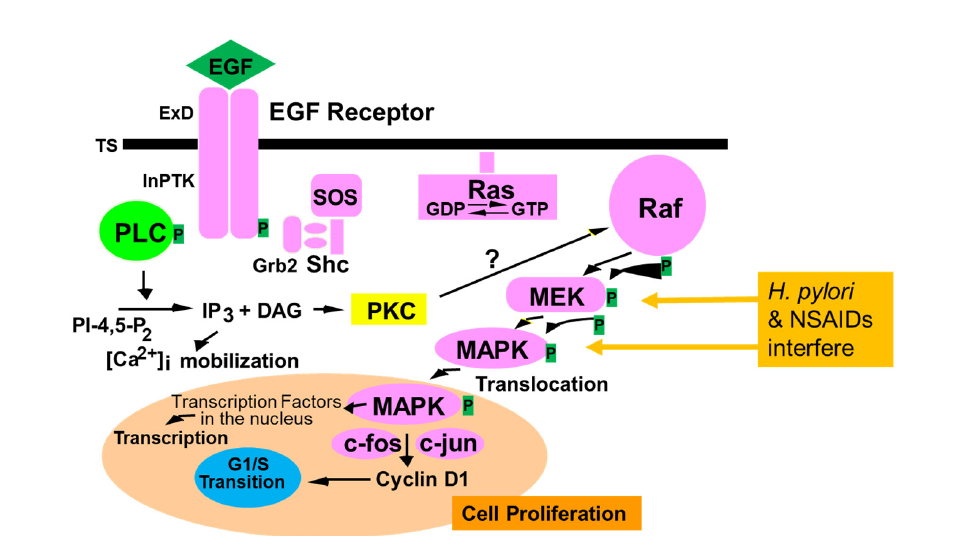
Figure 5. Signaling pathway induced by the activation of EGF-R in gastric epithelial cells in the mucosa of the ulcer margin. NSAIDs and H. pylori interfere with this signaling pathway and inhibit ulcer healing.